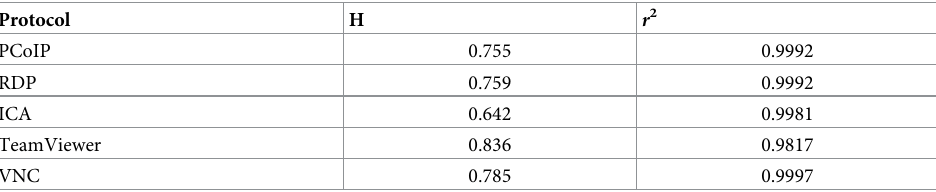
Table 7. Estimation of Hurst parameter for mixture of 30 users from each